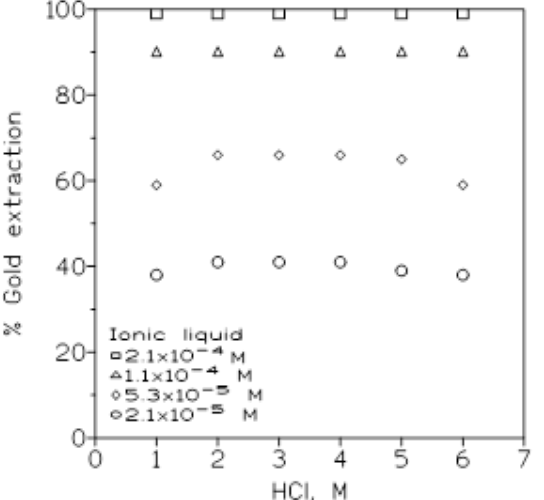
Figure 2. Gold extraction at different HCl and ionic liquid concentrations. Aqueous phase: 5.1 × 10 −5 M gold in HCl. Organic phase: different ionic liquid concentrations in toluene. Temperature: 20 °C. Time: 10 min. V org /V aq : 1.